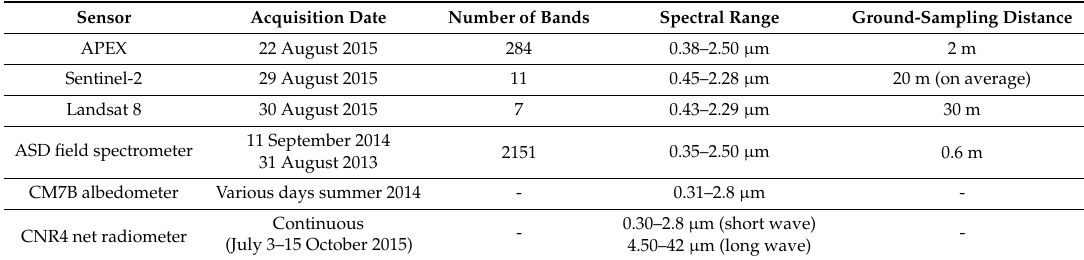
Figure 1. Overview of the two study sites ( a ) Findelengletscher and ( b ) Glacier de la Plaine Morte and ( c ) their location within Switzerland. Elevation bands with 100 m spacing (coloured), profiles (solid line and crosses) and location of weather stations (star) are shown for both glaciers. Table 1. Imaging and non-imaging radiation measurements. Number of bands refers to available surface reflectance spectral bands.